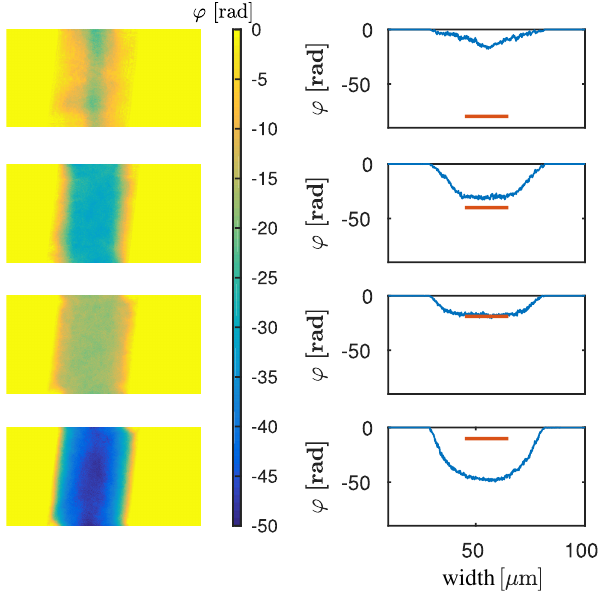
Figure 3. Left : phase reconstructions for the green marked region of interest in Figure 2 retrieved with the following energies (from top to bottom): E = [ 2.7;4.7;11.8;22.0 ] keV. Right : lineplots (blue) of the retrieved phase, which is shown in the Left images, and theoretical phase at the centre of the wire